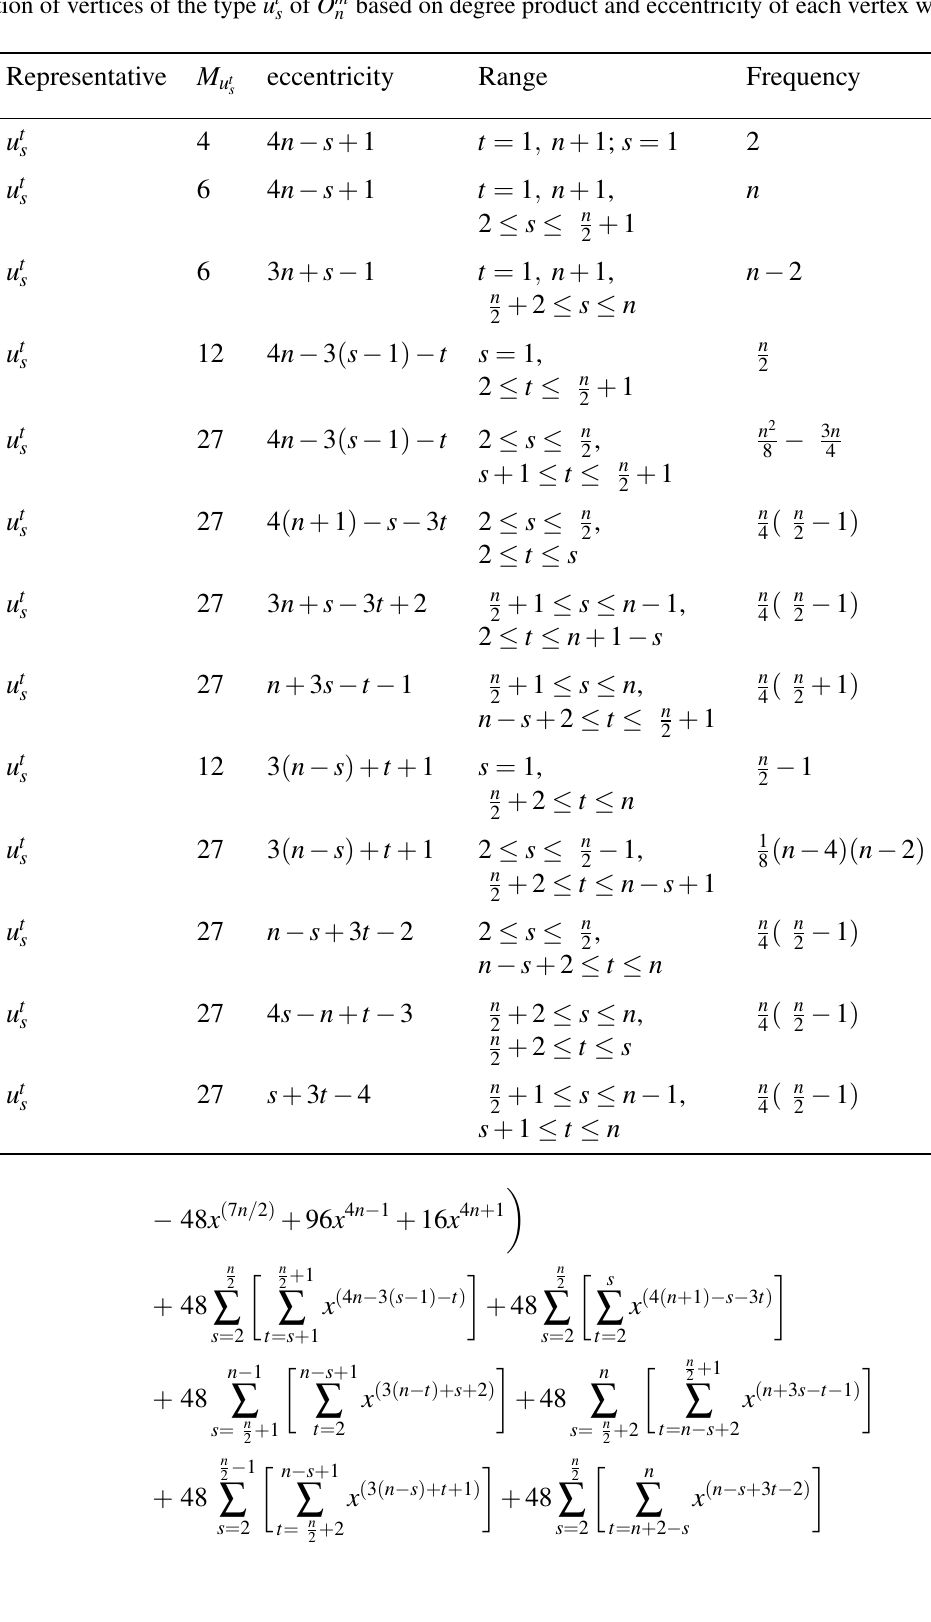
of O m based on degree product and eccentricity of each vertex when n ≡ 0 ( s n